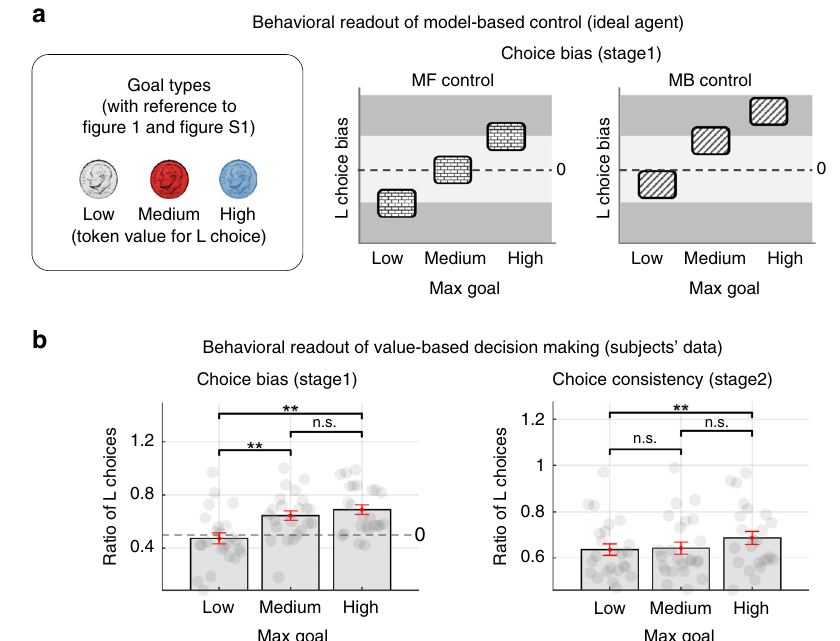
Fig. 2 Behavioral results — choice bias and choice consistency. a Predicted choice bias patterns of model-free (MF) and model-based (MB) control, calculated for the three goal conditions de fi ned as the trials according to which coin has the maximum monetary outcome value (low, medium, and high token value for the L choice). Owing to the asymmetric association between outcome states and coin types (For full details, see Supplementary Methods — Choice bias), participants would exhibit distinct choice bias patterns for each goal condition that distinguishes model-based from model-free control; the MF control agent would exhibit a balanced choice bias pattern, whereas the MB control agent would show a slight left bias pattern. For full details of this measure, refer to Supplementary Methods — Behavioral measure. b Participants ’ choice bias and choice consistency, conventional behavioral markers indicating reward-based learning. Error bars are SEM across subjects. The prediction about the choice bias matches subjects ’ actual choice bias (the left of the below fi gure). In particular, the data show a clear left bias pattern, rejecting the null hypothesis that subjects used a pure model-free control strategy. This bias is also re fl ected in choice consistency (the right plot). These results also indicate that participants ’ choice behavior is guided by reward-based learning more